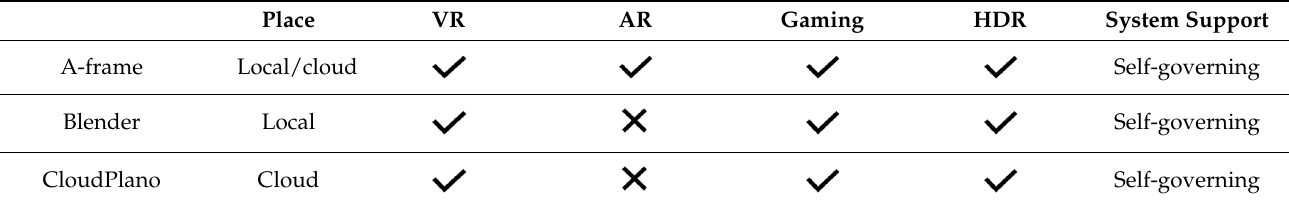
Table 3. Analysis of digital resources based on the metaverse concept.